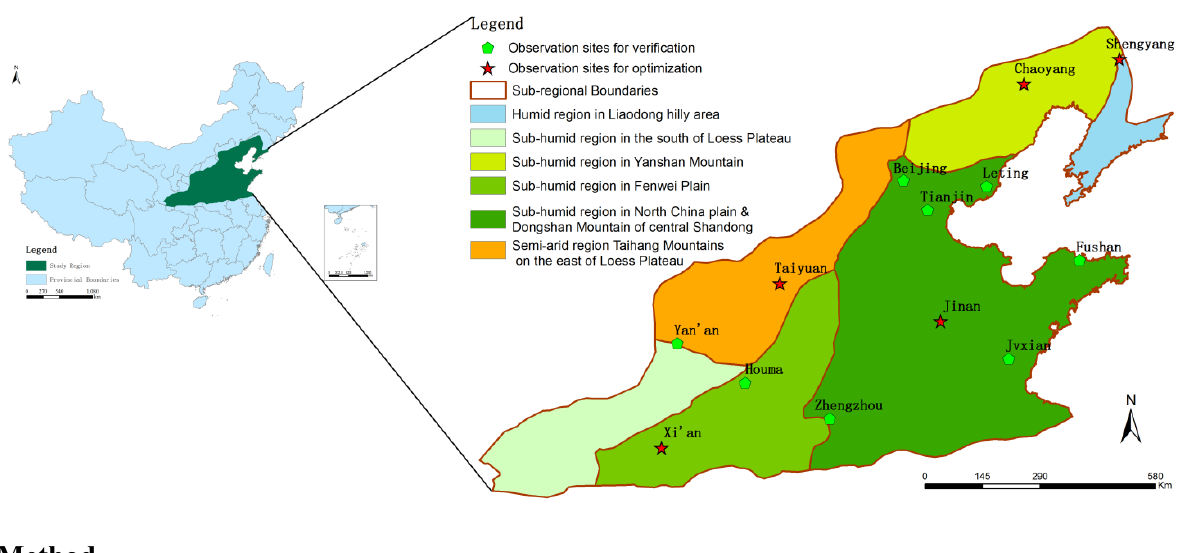
Figure 1. Study area and distribution of observation